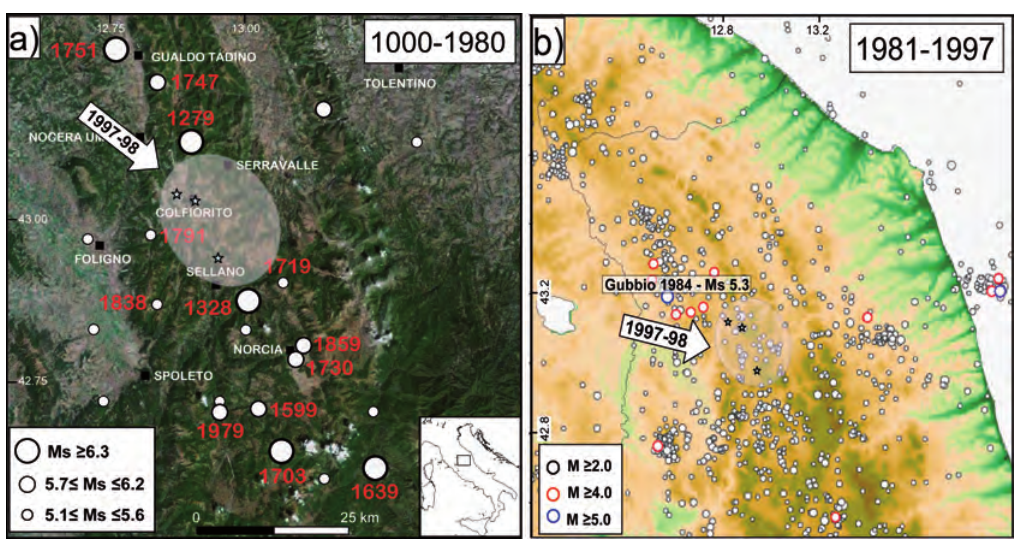
Fig. 1a,b. a) Historical and pre-1981 instrumental earthquakes (CPTI Working Group, 2004) and b) 1981-1997 instrumental seismicity (Castello et al. , 2005) within and surrounding the area of the 1997-1998 seismic se- quence, indicated by the shaded area (stars are the epicenters of the three